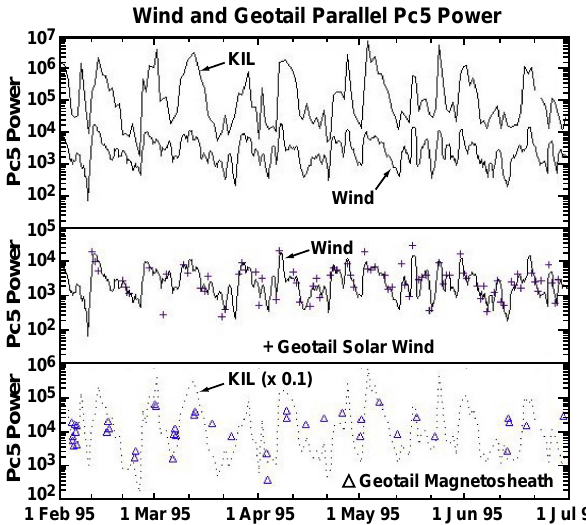
Fig. 2. Top panel: Pc5 pulsation power at Kilpisjarvi ground- based station (upper curve) compared to parallel Pc5 power at Wind (lower curve). Middle panel: parallel Pc5 power at Wind (curve) and Geotail (crosses) with both in the solar wind. Bottom panel: Pc5 pulsation power at Kilpisjarvi (dotted curve) and parallel Pc5 power at Geotail in the magnetosheath (triangles).